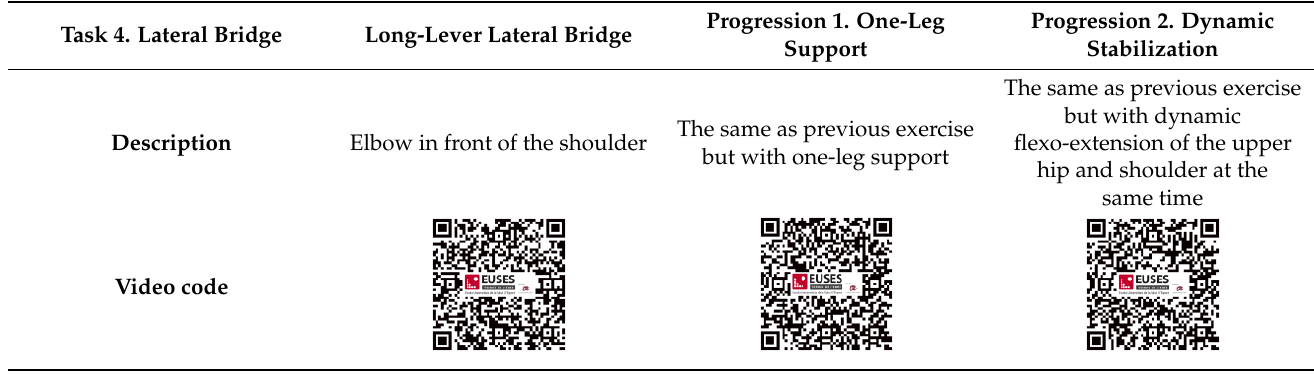
Table 9. Description and methodologic criteria of GCS group’s task 4 and its progressions.